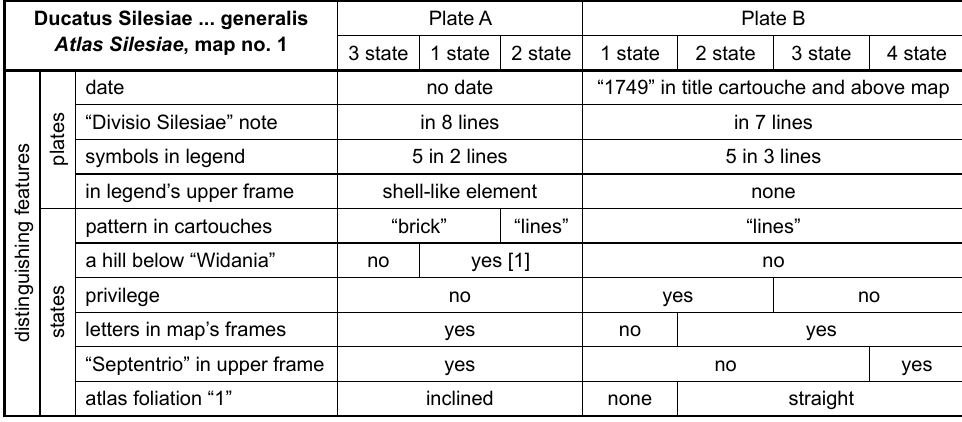
Table 1. General map of Silesia – plates and states Ducatus Silesiae ... generalis Atlas Silesiae , map no.